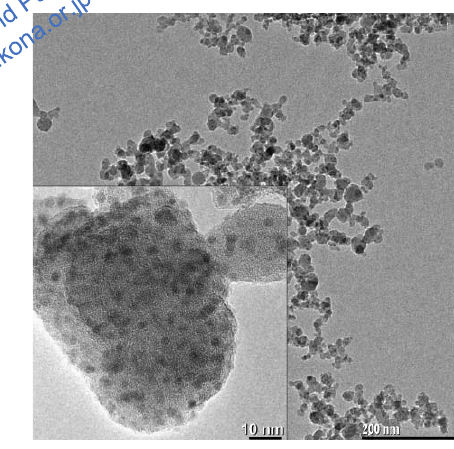
Fig.7 TEM micrograph of γ -Fe 2 O 3 /SiO 2 nanoparticles. The overview shows the typical fractal geometry of fumed silica, while the inset gives a detailed insight into the homogeneous dispersion of iron oxide (dark specks) within the silica matrix.